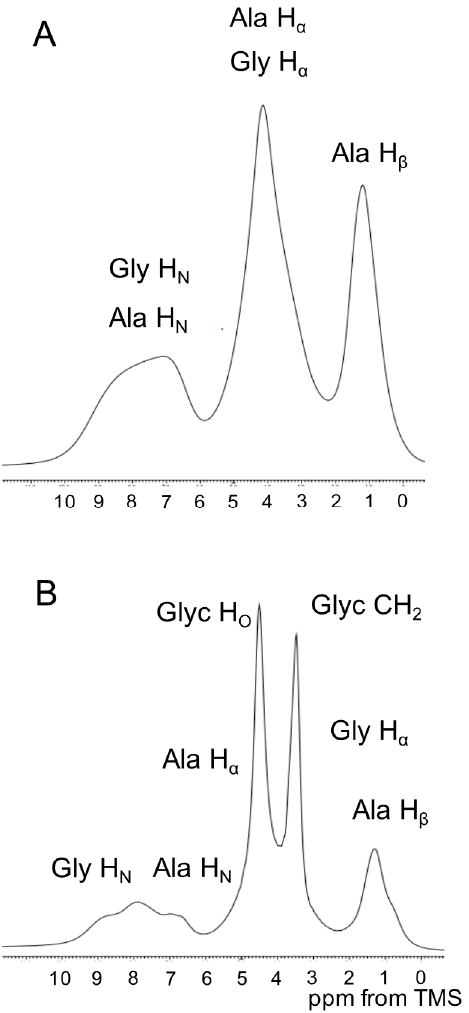
Figure 5. 1 H single pulse NMR spectra of ( A ) SF; and ( B ) Glyc (29 wt %)-blended SF films in the solid state. The assignments are given on top of the peaks. The detailed assignments and the chemical shifts of the 1 H NMR peaks are summarized in Table 1 ( 1 H chemical shift).